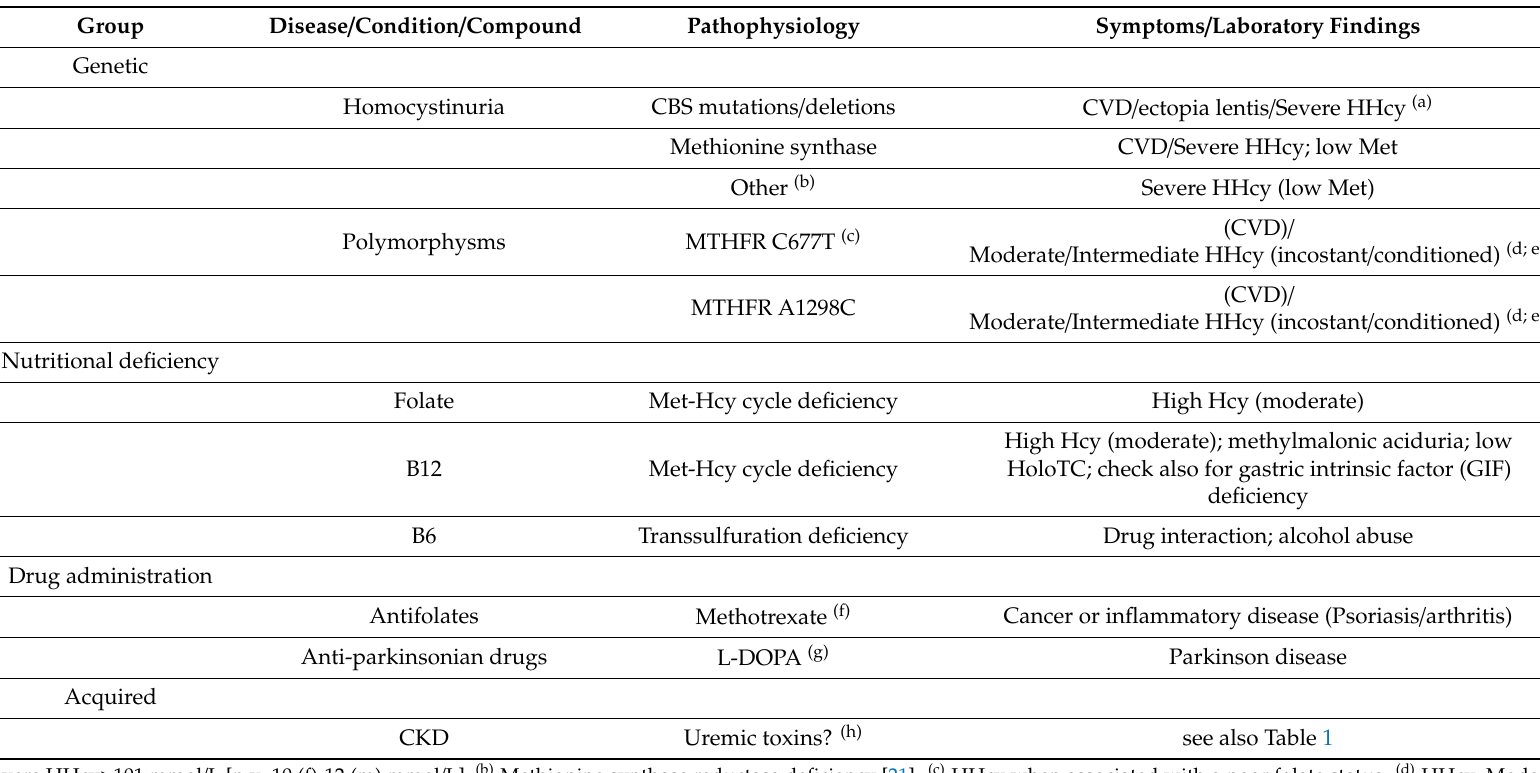
Table 2. Principal causes of hyperhomocysteinemia (HHcy) and associated disease